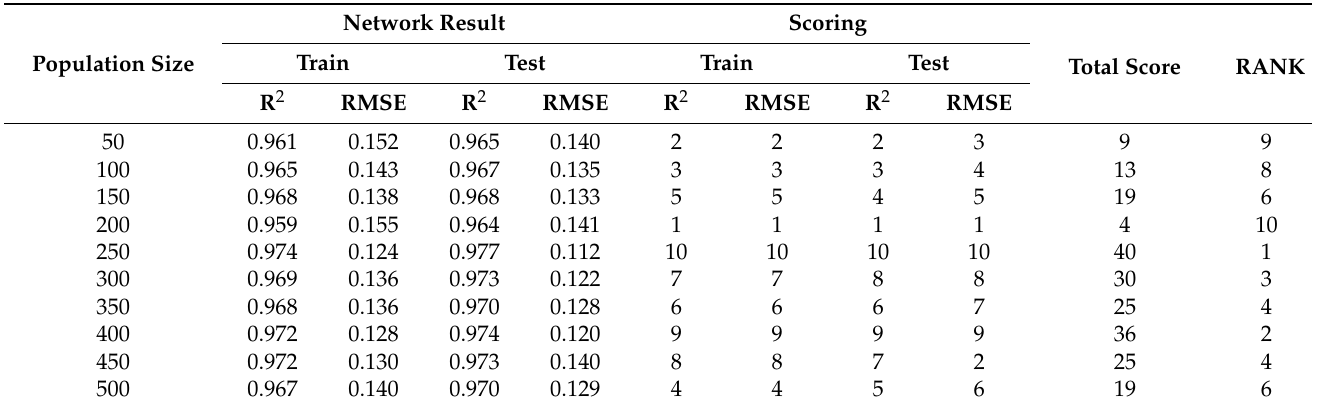
Table 3. The network results for the